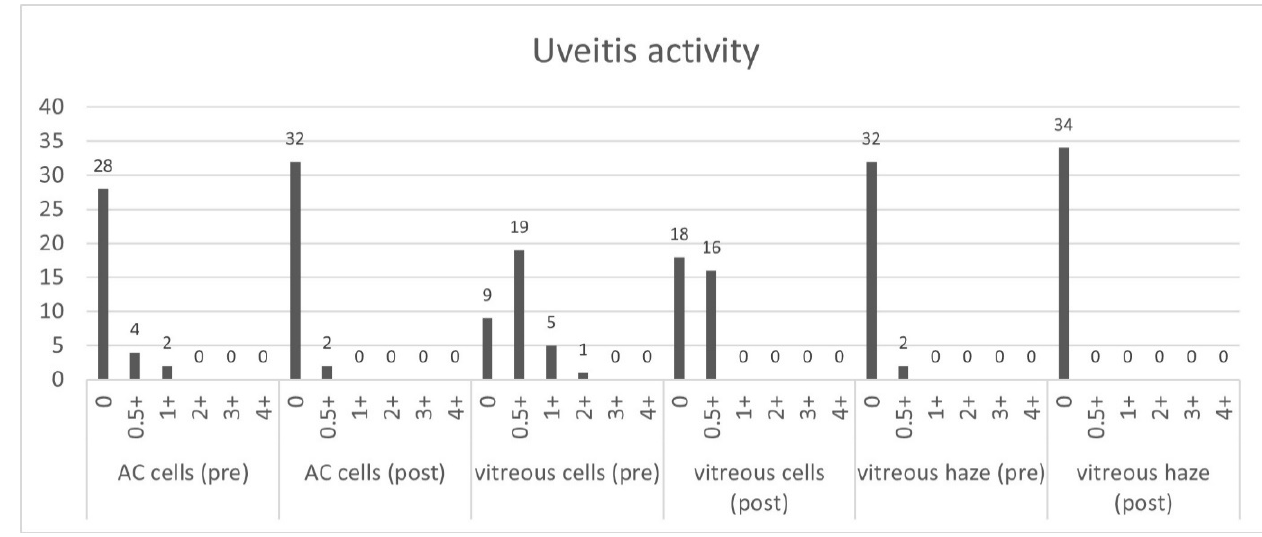
Figure 6. Uveitis activity pre- and post-FAc implantation.